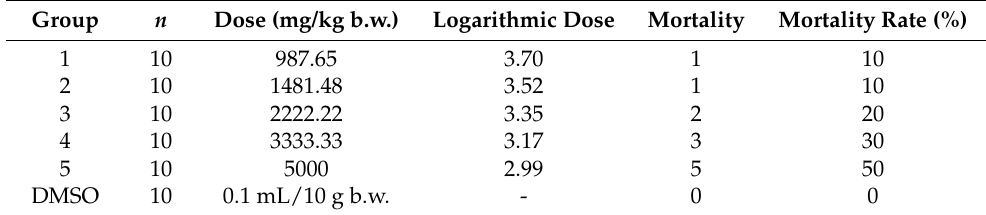
Table 3. Oral single-dose toxicity of NPDM in mice.